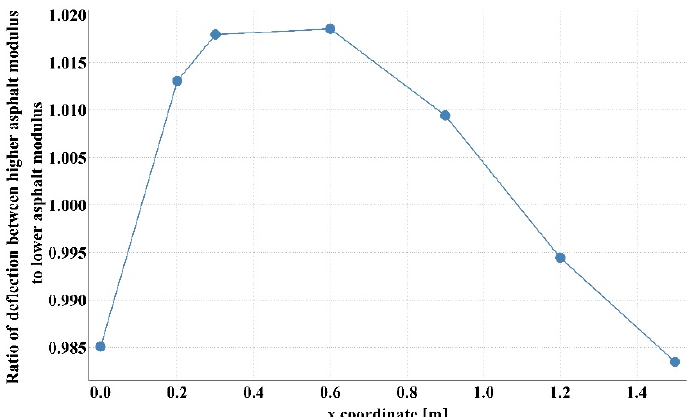
Figure 4. Deflection basin for the case with higher asphalt layer modulus—lower aggregate base course modulus and lower asphalt layer modulus—higher aggregate base course modulus.